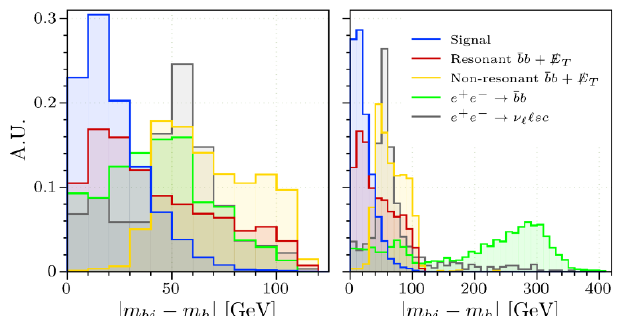
Figure 4. Normalised distributions of (cid:1) mh after the =E and 500 GeV (right) with polarisation